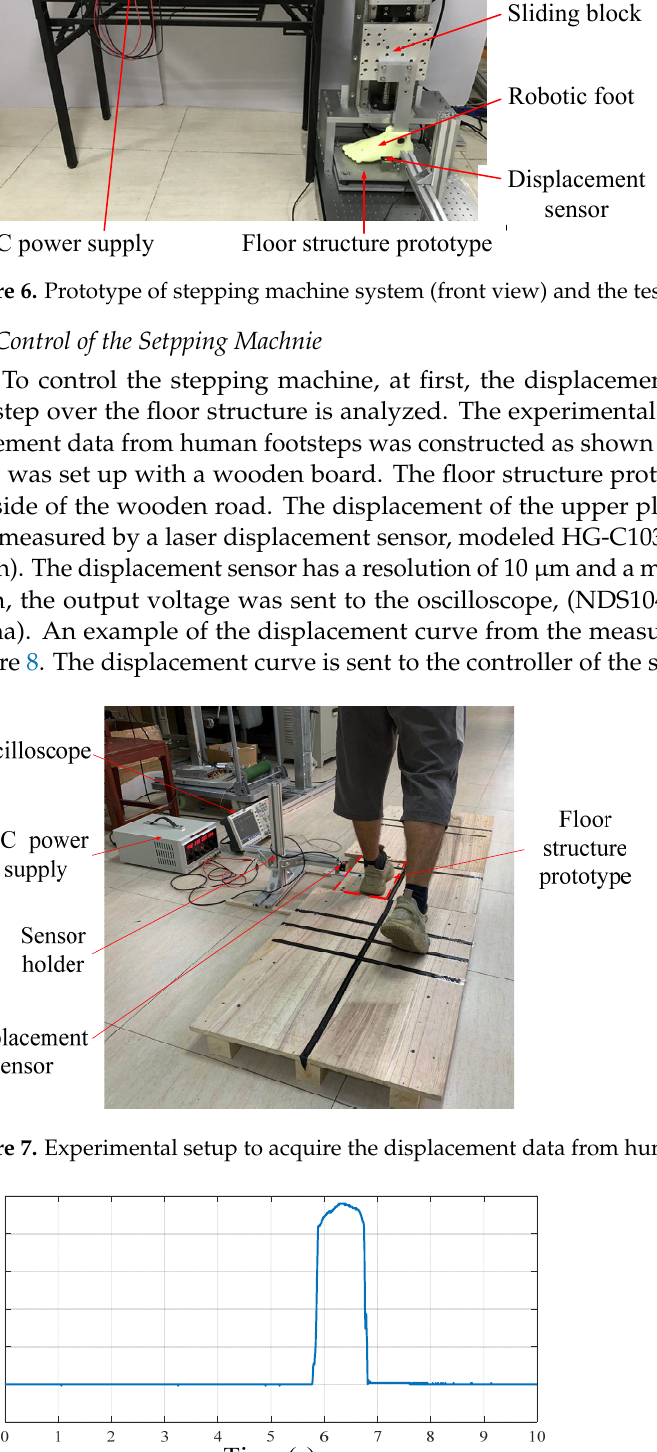
7 of 15 Figure 5. Structure of the stepping machine (side view). The prototype of the stepping machine system was built as shown in Figure 6. The stepping machine was dimensioned 60 cm × 80 cm × 120 cm. For the lead screw, the rod is made of Aluminum 6063; the helical pitch is 10 mm with a resolution of 0.03 mm. To meet the requirement of the stepping speed and force of the stepping machine, the motor should output a rotation speed that is larger than 1200 r/min and a torque larger than 1.2